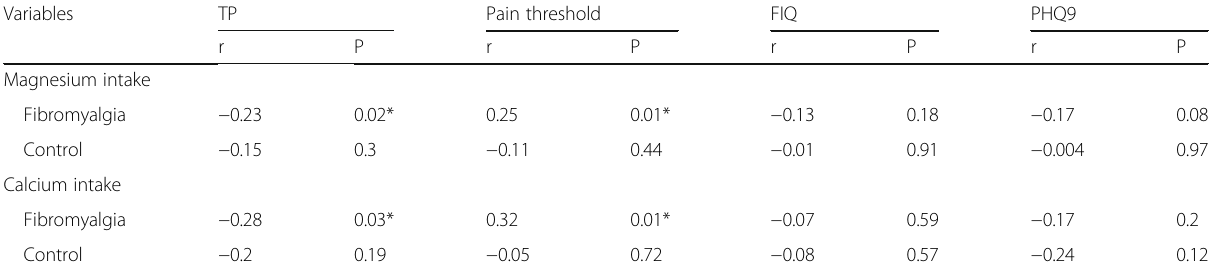
Table 2 Relationship between magnesium and calcium intake with the variables: pain, quality of life and risk of depression Variables